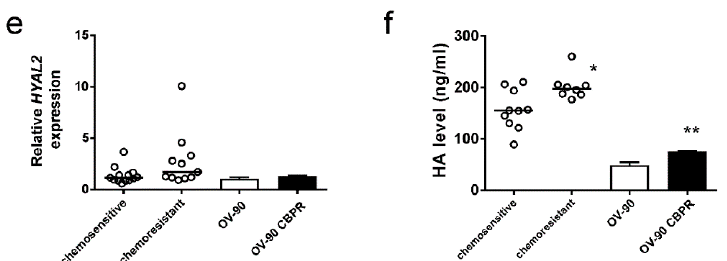
Figure 2. Hyaluonan (HA) synthase and hyaluronidase expression and HA production in chemosensitive and chemoresistant serous ovarian cancer cells. Expression in chemotherapy-resistant primary serous ovarian cancer cells compared to chemotherapy-sensitive cells and OV-90 cells made resistant to carboplatin (OV-90 CBPR). HAS1 ( a ), HAS2 ( b ) HAS3 ( c ), HYAL1 ( d ), and HYAL2 ( e ) *, HAS2 ( p = 0.0218, Mann Whitney U test) and HAS3 ( p = 0.0107, Mann Whitney U test) but not HAS1 expression ( p = 0.879, Mann Whitney U test) was significantly increased in chemoresistant cells compared to chemosensitive cells. **, HAS2 ( p = 0.021, Student t test) and HAS3 ( p < 0.0001, Student t test) were significantly increased in OV-90 CBPR compared to parental cells. HYAL1 and HYAL2 expression was not significantly di ff erent between the chemosensitive and chemoresistant primary cancer cells nor the OV-90 cell lines. The bars for the primary cells specify the median values in each group and are expressed as the mean fold change from RNA samples ( n = 6–9) from three independent experiments. Data for OV-90 cells are expressed as the mean fold change ± SEM from 7–12 individual RNA samples from 2–3 independent experiments. ( f ) HA levels measured by ELISA assay in conditioned media. *, significantly increased in primary chemoresistant ( n = 8) compared to chemosensitive ( n = 10) serous ovarian cancer cells ( p = 0.043, Mann Whitney U test). **, significantly increased in OV-90 CBPR conditioned media compared to parental cells ( p = 0.0227, Mann Whitney U test).